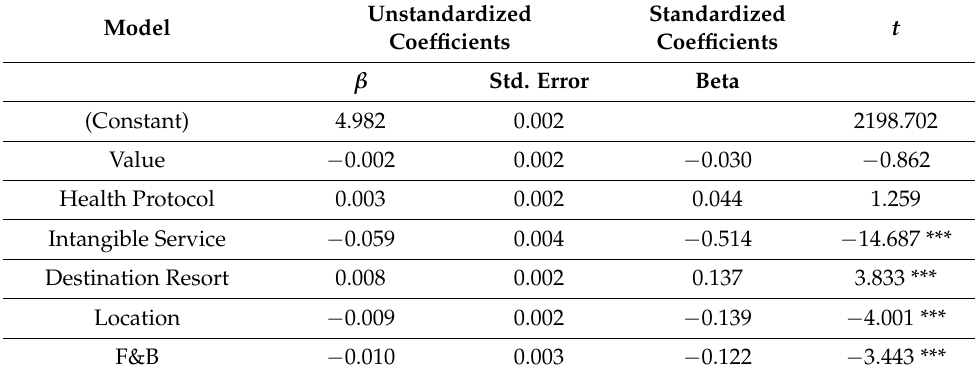
Table 7. Linear Regression Analysis